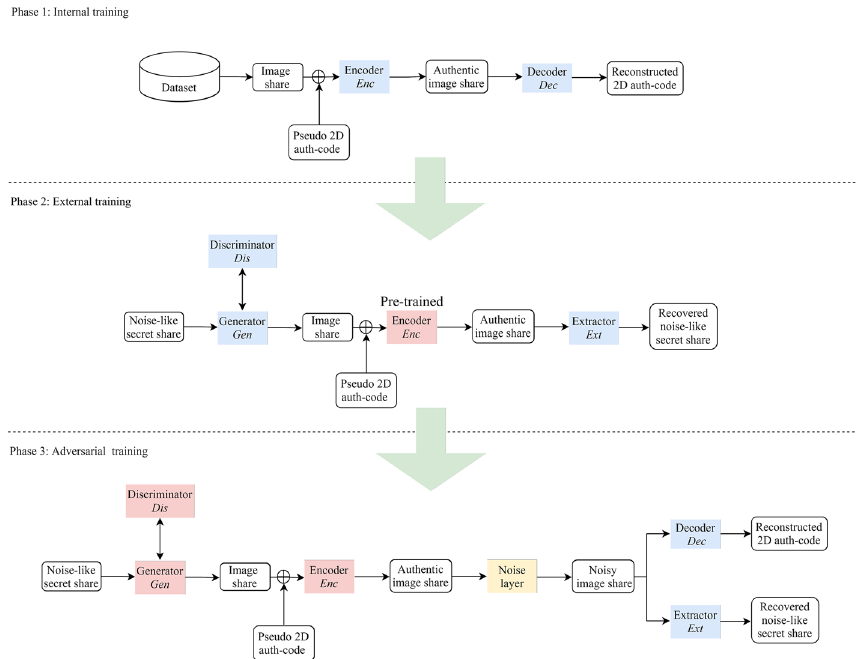
Fig. 3 Internal, external, and adversarial training